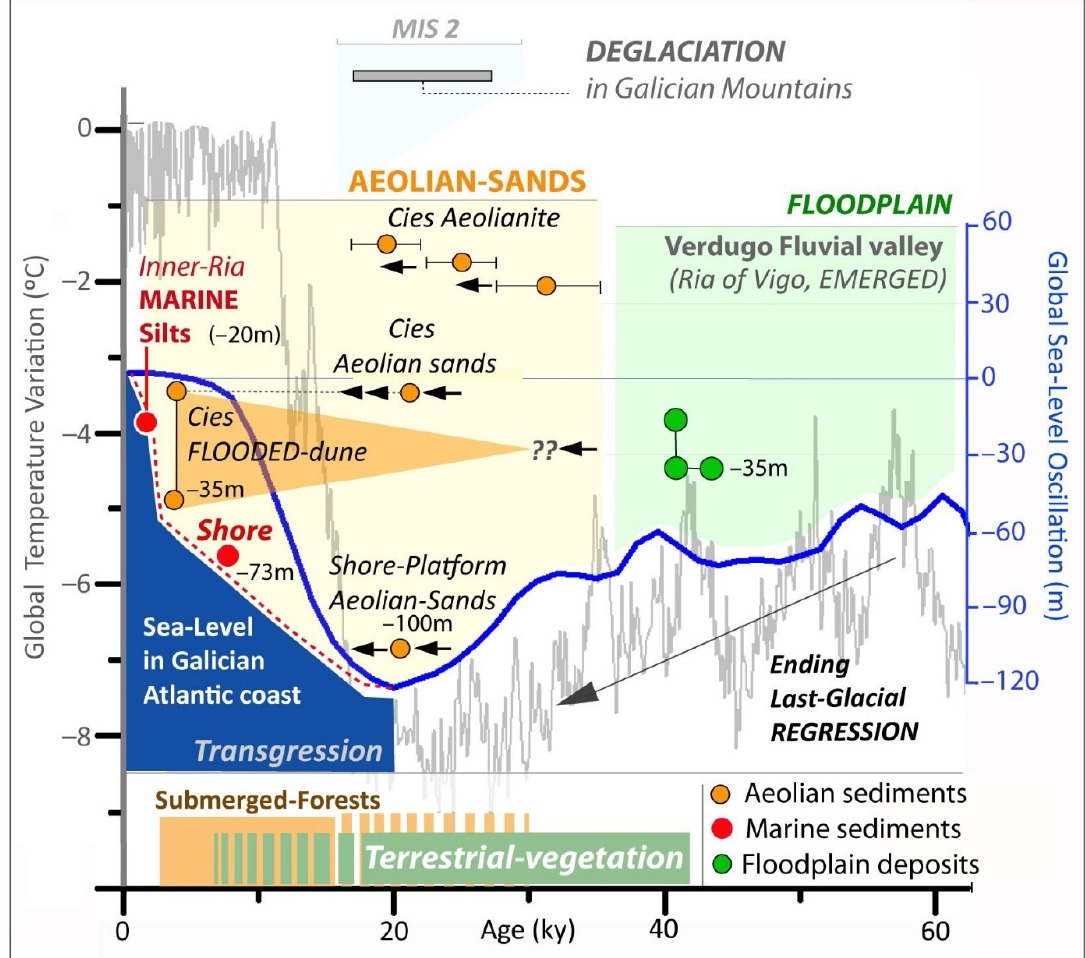
Figure 7. Local sedimentary record of the last 45 ky (continental and marine) in the Cies Islands and Ria de Vigo, compared to trends in the global climate record [69] indicated by temperature variations from Vostok ice cores [70] (grey line) and sea-level oscillations [71] (blue line), including the deglaciation processes in the mountains of Galicia and northern Portugal [72,73] at MIS2 [74]. Sedimentary record at the end of the Last Glacial period are represented by (i) floodplain deposits (green areas) and (ii) aeolian sands (yellow area) ([8,10,12,15] and this paper). Submerged forests buried by dunes from 30–3.5 ky along the coasts of Galicia and the northern Portugal [4]. Dark-blue area under the red dashed line shows the sea-level rise in the Ria de Vigo during post-glacial transgression, from the local record.